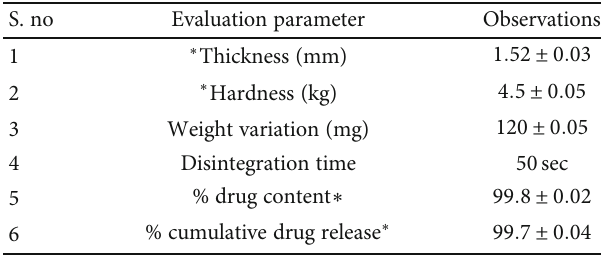
Table 5: Characterization of the marketed tablets of Duloxetine HCl (Symbal 30).